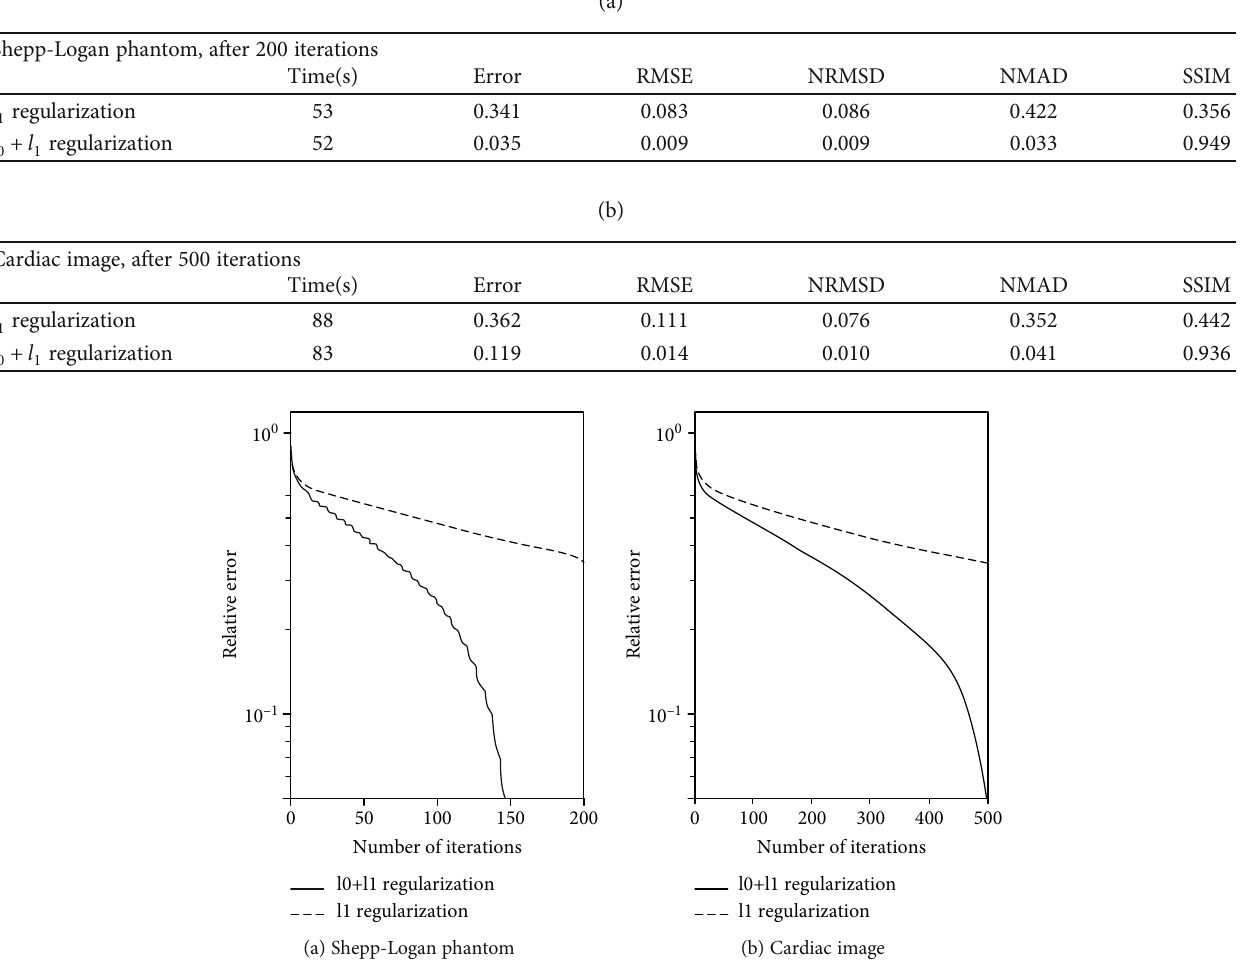
Figure 2: Relative error v.s. iteration number in reconstruction by two algorithms. (a) Shepp-Logan phantom. (b) Cardiac